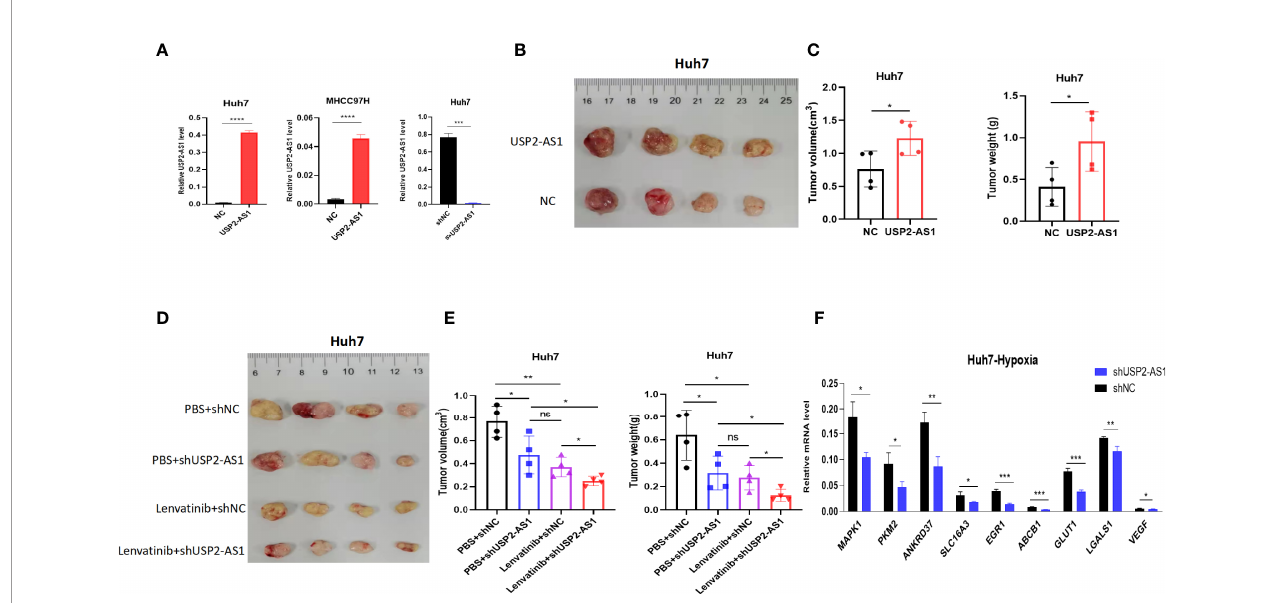
FIGURE 6 | USP2-AS1 knockdown can increase the ef fi cacy of lenvatinib in mice tumor xenograft model. (A) Construction of Huh7 and MHCC97H cell lines overexpressing USP2-AS1 and Huh7 USP2-AS1 knockdown cell lines. (B, C) Tumor volume and tumor weight of NC (Normal Contrast) or USP2-AS1 overexpressing Huh7 cells in the xenograft mouse model (n = 4). (D, E) Tumor volume and tumor weights of NC or USP2-AS1 overexpressing Huh7 cells in a xenograft mouse model (n = 4) with PBS or Lenvatinib. (F) Several downstream target genes of HIF1 a were down-regulated following USP2-AS1 knockdown in Huh7 cell under hypoxia. Two-tailed Student ’ s t-test, *p < 0.05, **p < 0.01, ***p < 0.001, ****p < 0.0001, and ns, no statistically signi fi cant